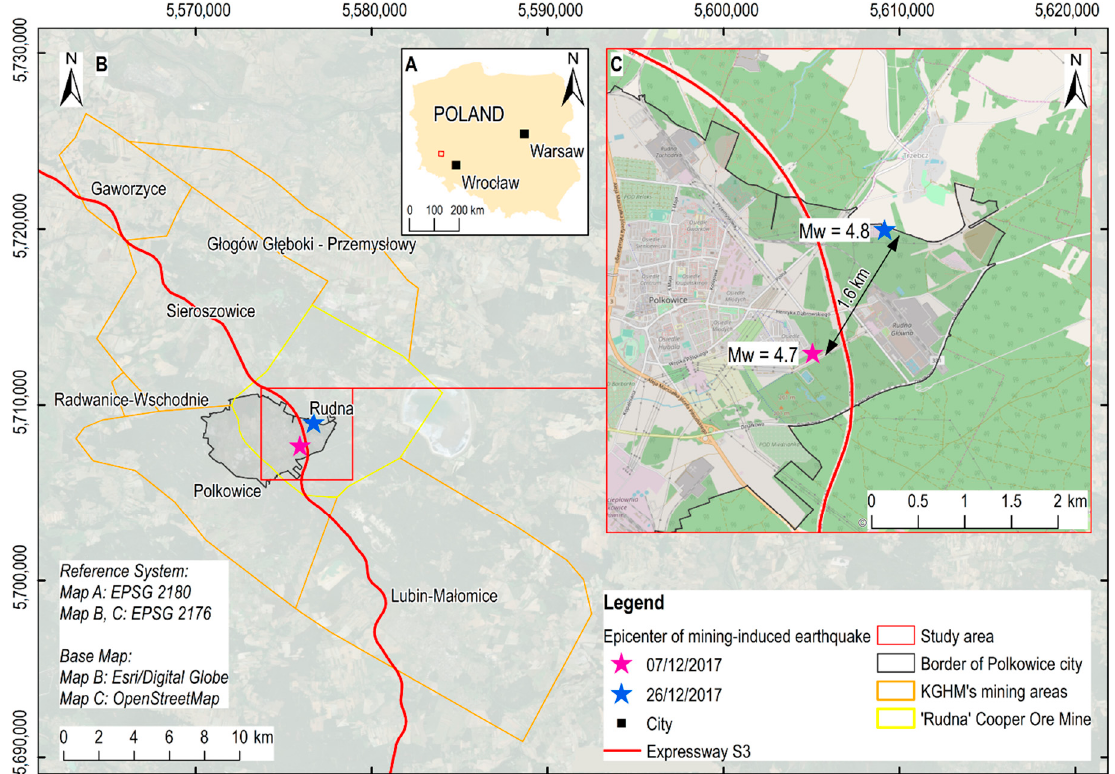
Figure 2. ( A ) Area of interest; ( B ) location of the area of interest, KGHM Company mining areas and expressway S3; ( C ) map of study area illustrating the epicenters of mining-induced earthquakes against the background of the town of Polkowice.